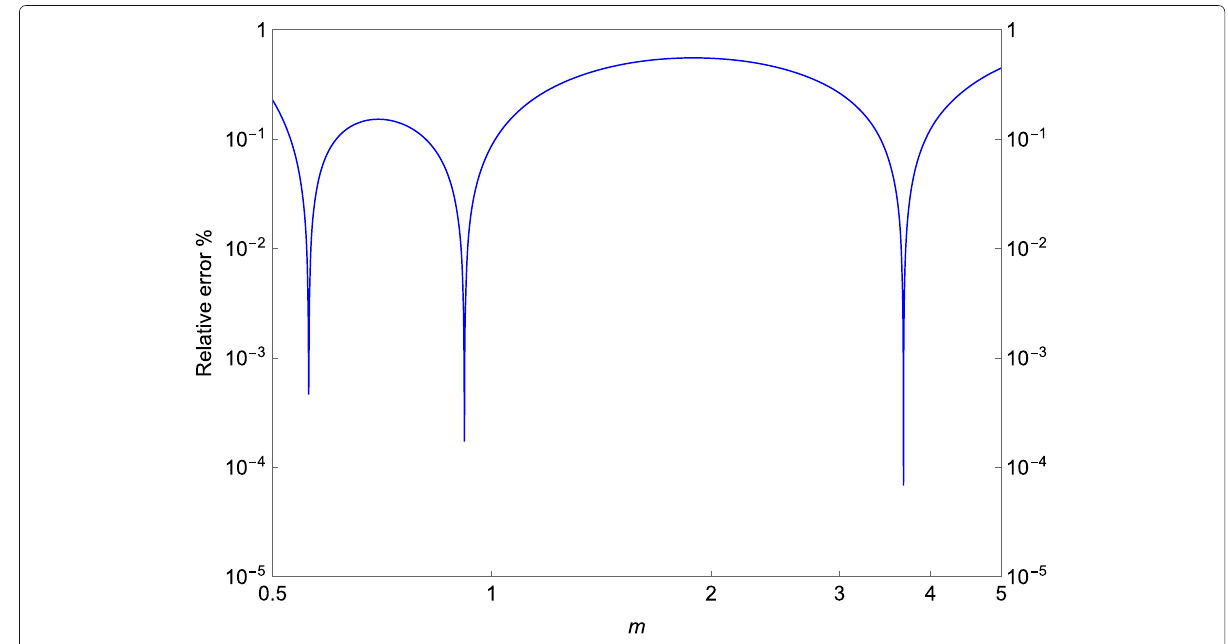
Fig. 2 Relative error of the estimator of the fading parameter, m , as a function of m